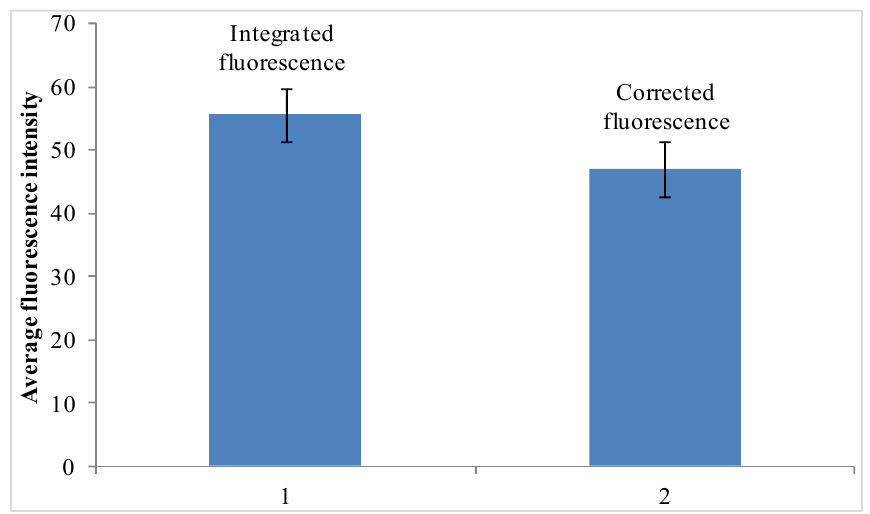
Figure 9. Average fluorescence values from the microfluidic chip.